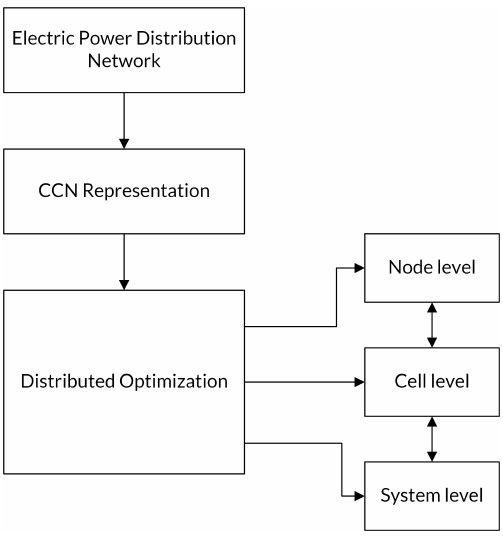
Figure 3. Overview of the proposed DOF.